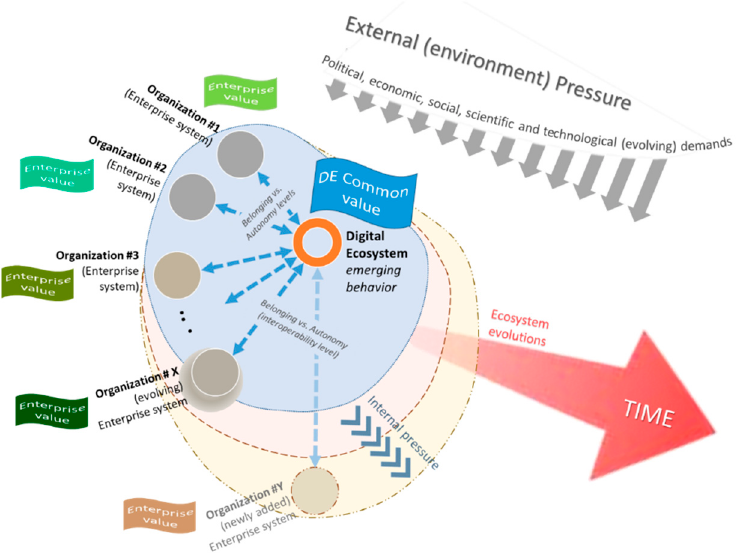
Figure 4. The evolutionary nature of a DE, its main elements, and the contextual pressure it must address .